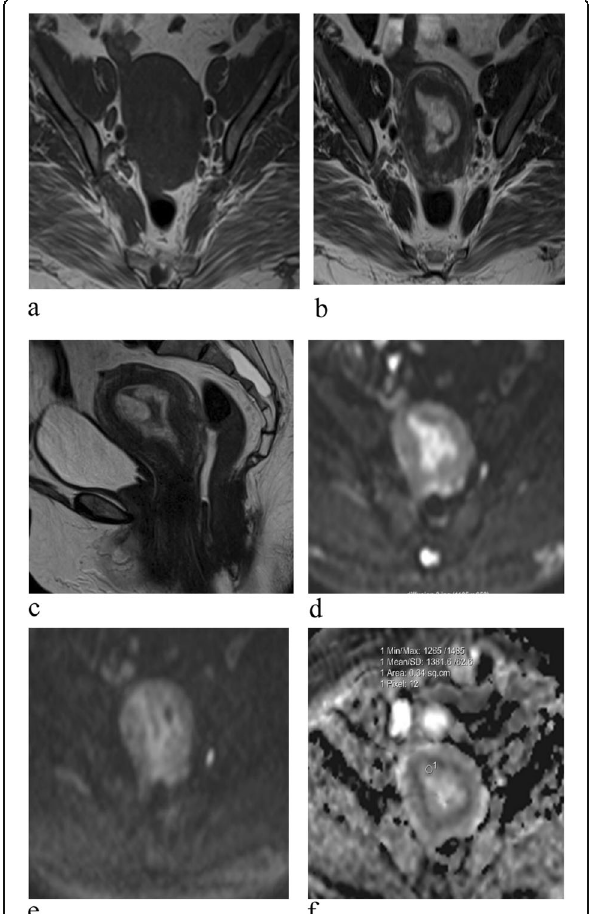
Fig. 4 a Axial T1-WI revealed slight hypointense signal intensity from the endometrial lesion. b Axial T2-WI and c sagittal T2-WI revealed an increase in endometrial thickness forming a mass lesion with a high SI and inner areas of low SI; there was infiltration of the junction zone less than 50% of the myometrium which was affected. d Diffusion-weighted imaging at b = 0 and e b = 1000 showed loss of the high SI of the endometrial lesion at increased b values (benign feature). f ADC mapping showed a high SI of the diagnosis: endometrial mass lesion with suspicious criteria at conventional MRI and benign features at DW and ADC images. Final diagnosis (according to histopathology): well-differentiated endometrial